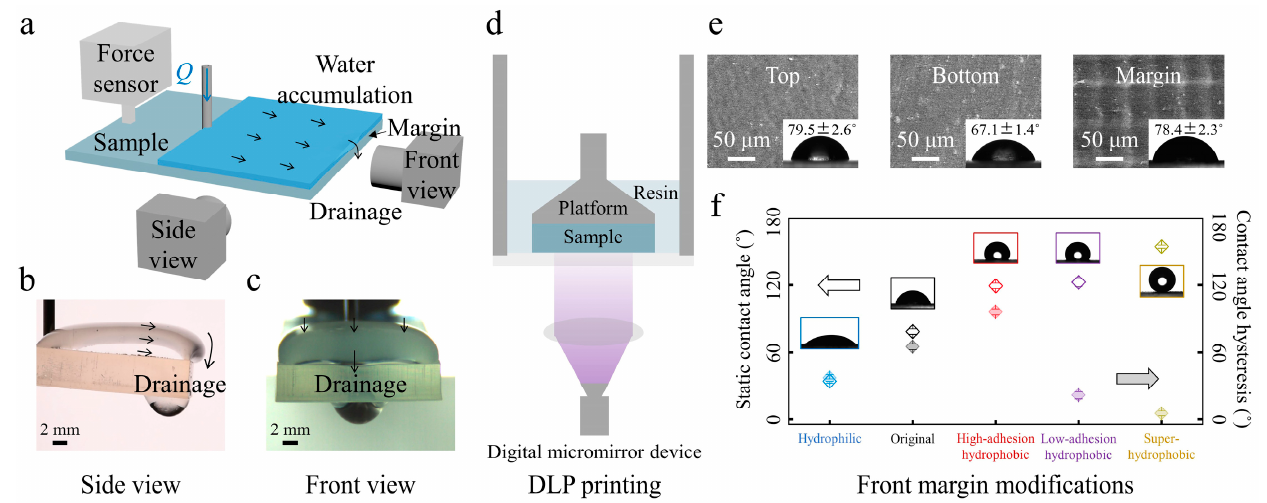
Figure 1. Experimental setup and material characterizations. ( a ) Schematic illustration of the experimental design. Injection water accumulates on the sample top and drains at the front margin at critical conditions. Selected essential snapshots of drainage from the side view ( b ) and the front view ( c ) for the original margin sample. ( d ) Schematic diagram of the DLP printing for sample fabrication. ( e ) Scanning electron microscope (SEM) images and corresponding water contact angles (inset) of the top surface, the bottom surface, and the front margin of the sample, respectively. ( f ) Static water contact angles and contact angle hysteresis versus different front margin modifications.